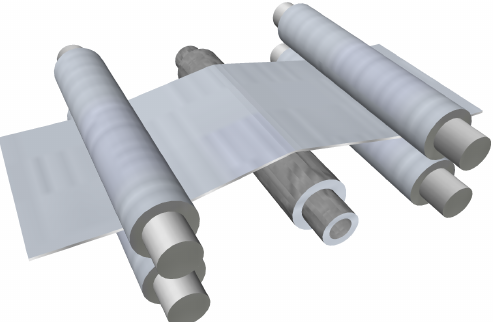
Figure 6. Roll-based flatness sensor (center) installed with a slight deflection of the flat-rolled product to ensure that radial force is generated, while the product is being